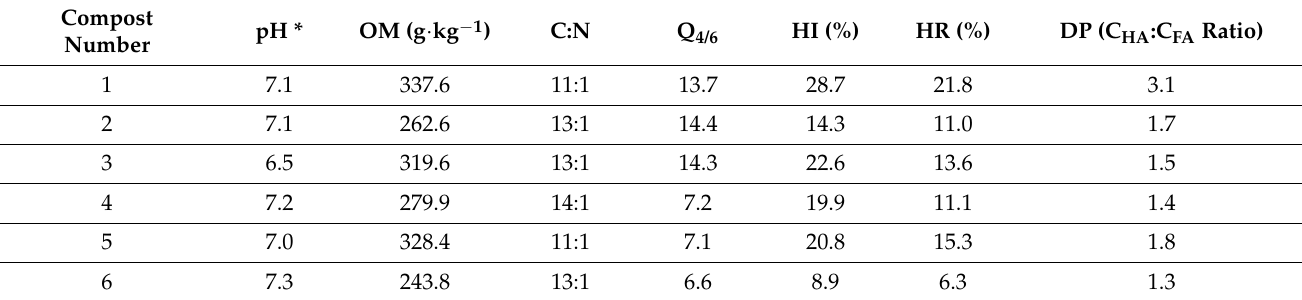
Table 3. Basic properties of the analyzed